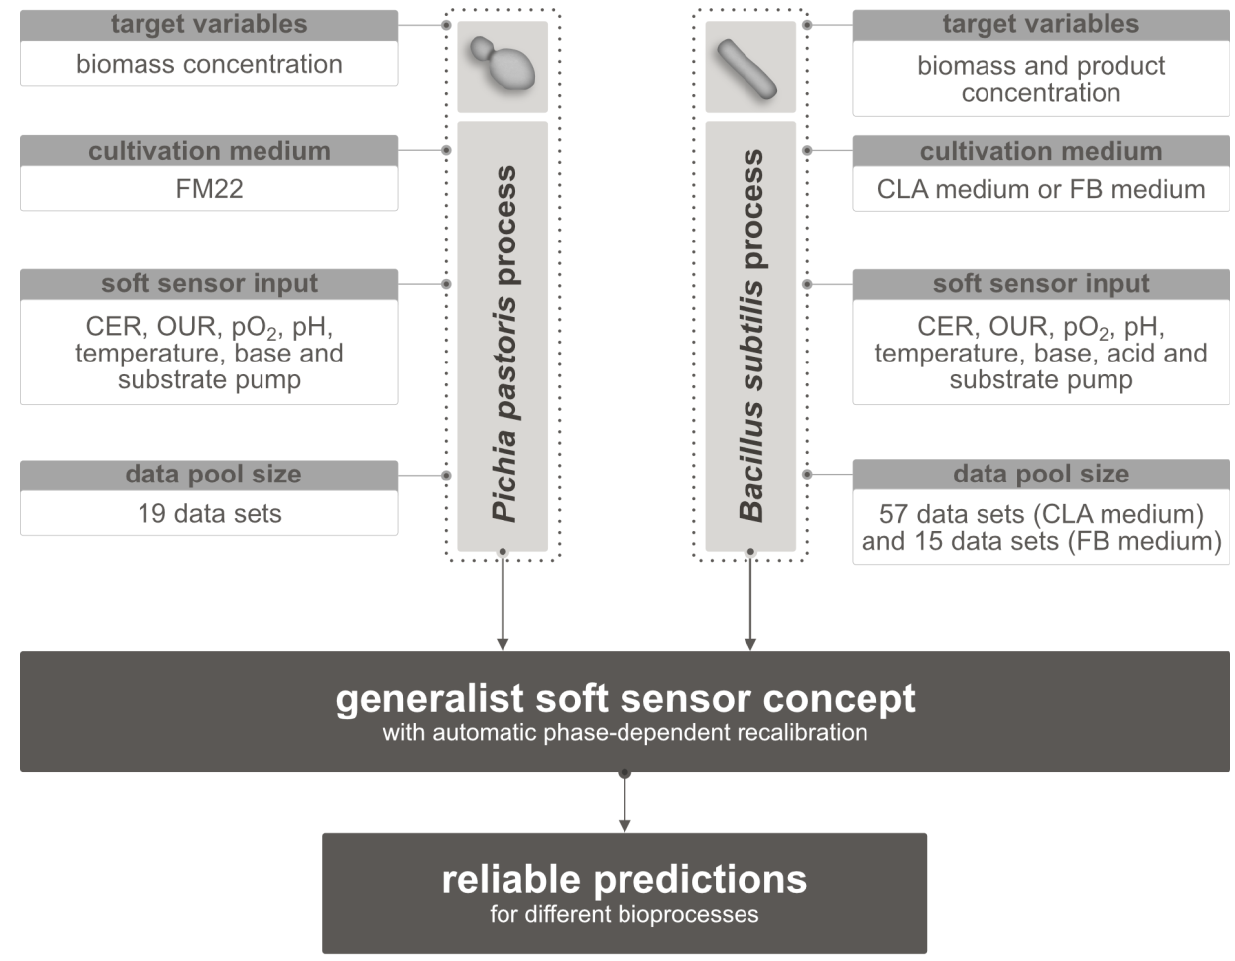
Figure 3. Overview of the different target variables, media, soft sensor input, and the data pool sizes of the bioprocesses. CER = carbon dioxide evolution rate; OUR = oxygen uptake rate.